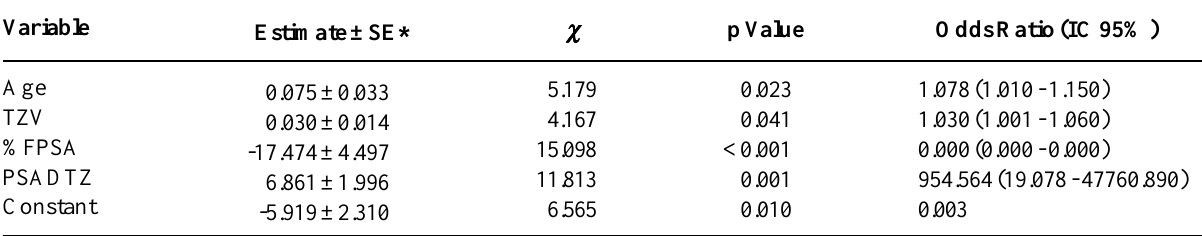
Table 5 – Multivariate logistic regression model (MLRM)